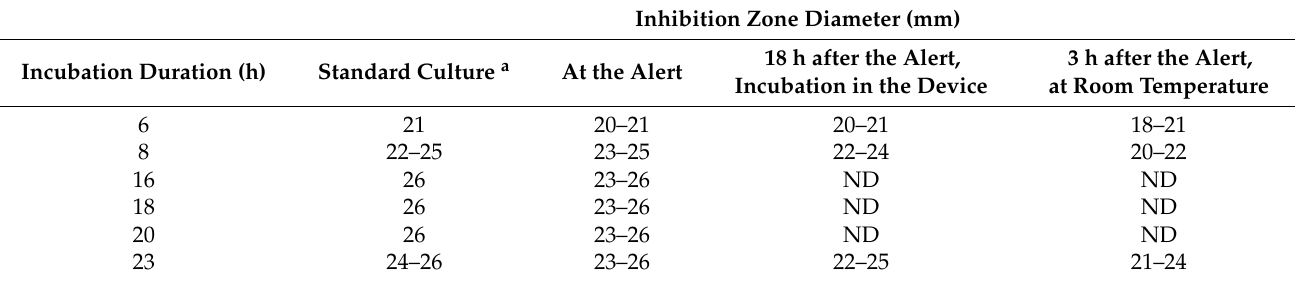
Table 5. Ciprofloxacin inhibition zone diameters of B. anthracis -positive blood cultures.